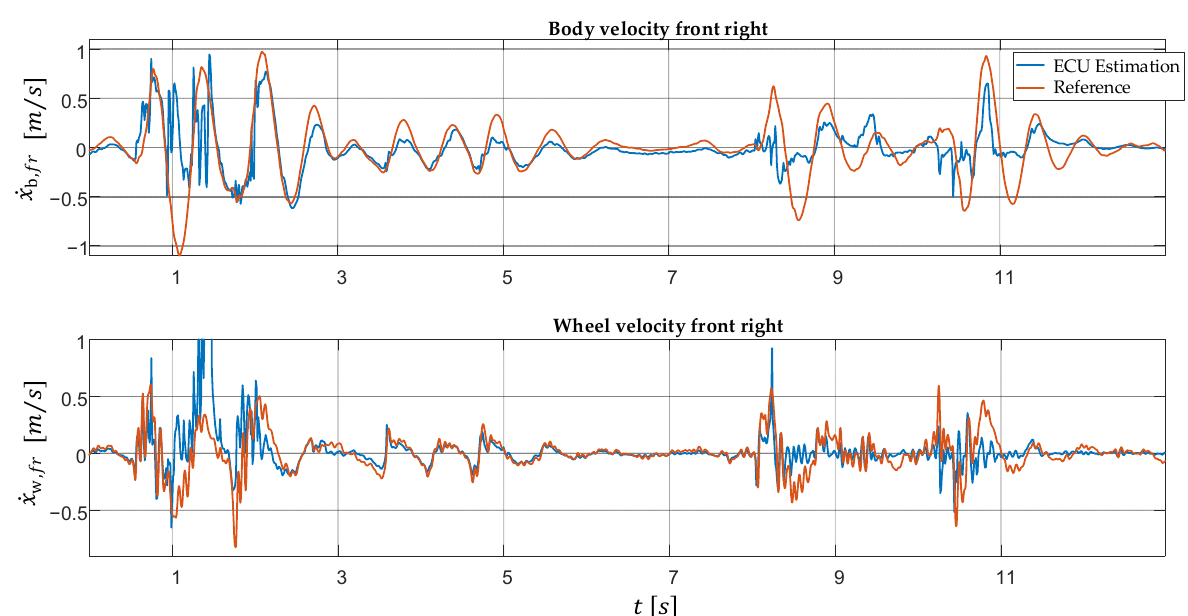
Figure 15. Comparative results from a test maneuver to validate the nonlinear Kalman filter.